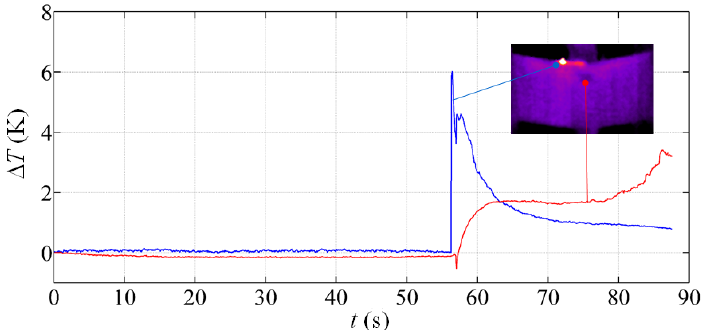
Figure 8. A two-points temperature plot: the blue curve refers to a point over the top specimen surface; the red curve refers to a point over the bottom specimen surface.